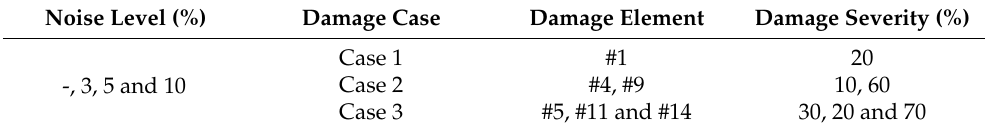
Table 3. Damage cases of the ASCE benchmark